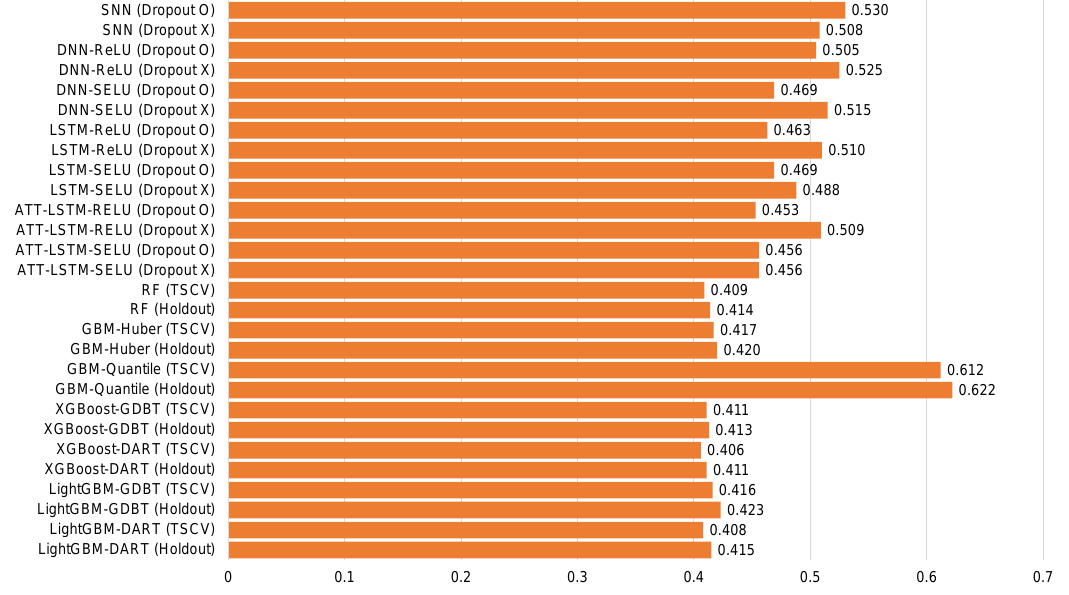
Figure 12. Average root mean square error for each model for Gosan-ri (MJ/m 2 ).